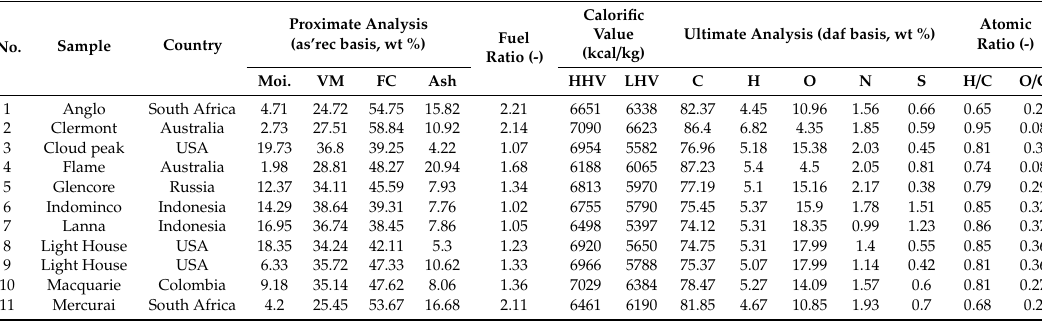
Figure 2. Van Krevelen plot of the samples. Table 1. Proximate analysis, calorific value, and ultimate analysis of coal